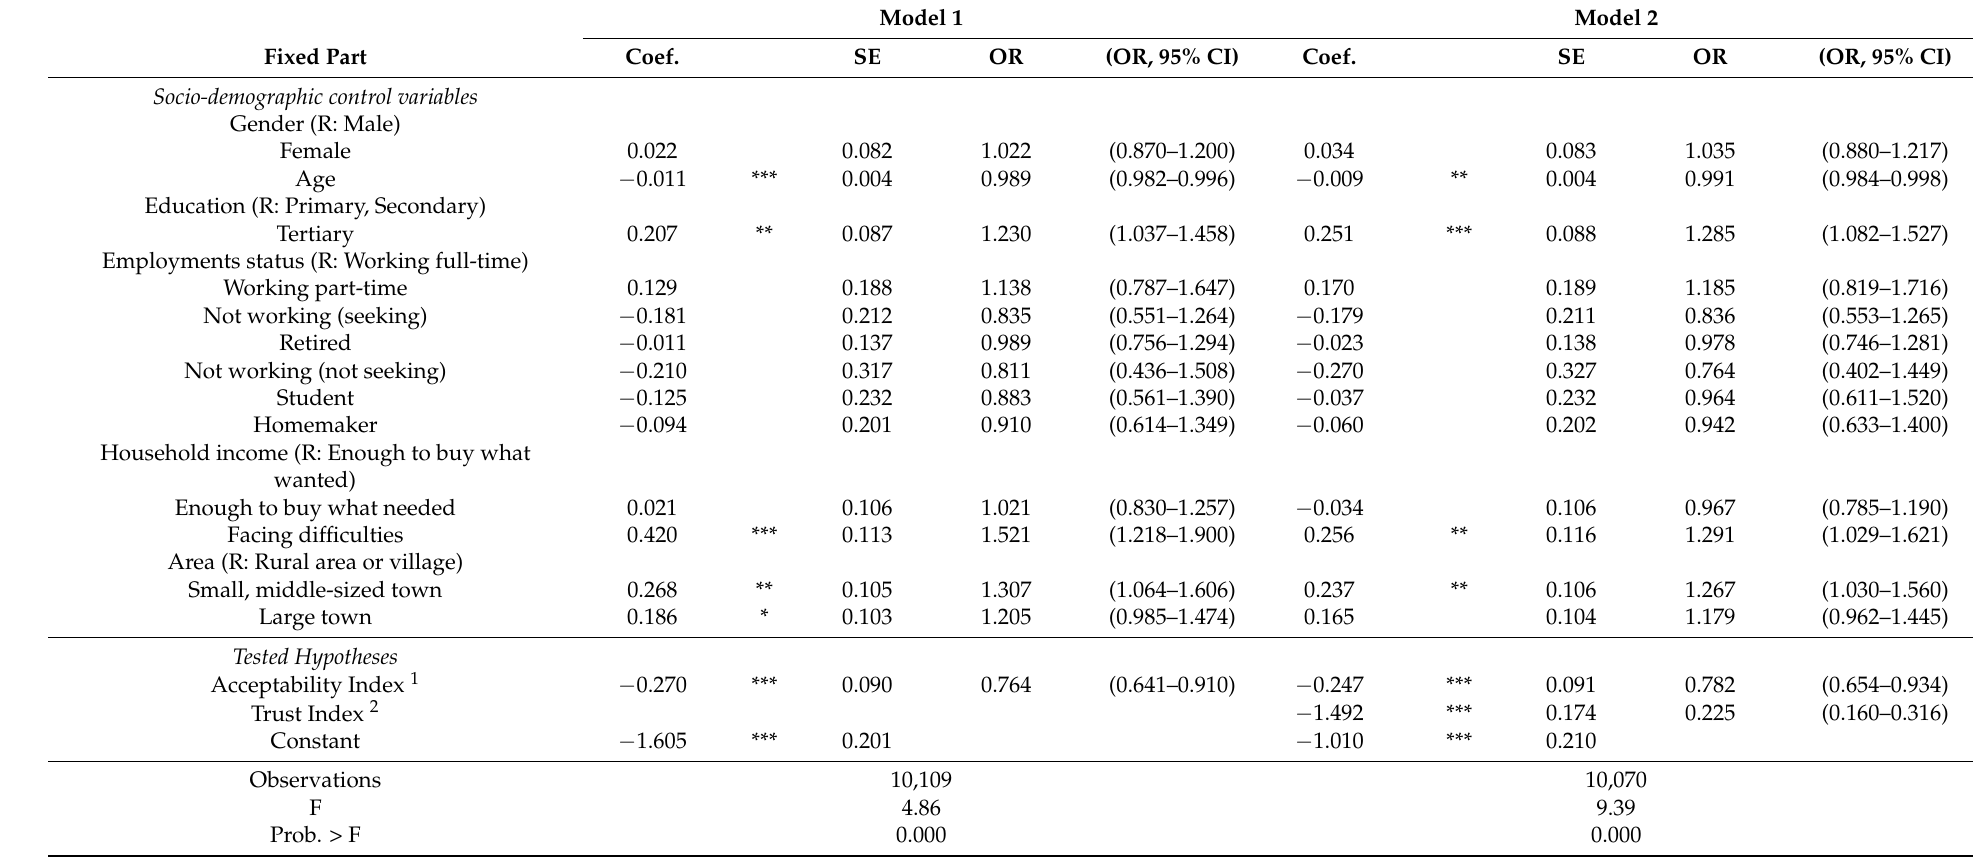
Table 4. Logistic regression of the probability to make informal payments for public healthcare services in Central and Eastern Europe. Model 1 Model